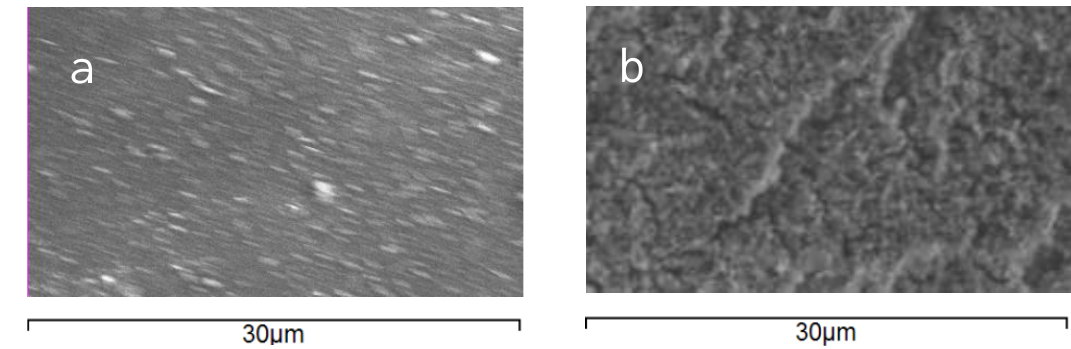
Figure 5. SEM images of MPF-34 membrane surface before ( a ) and after ( b ) filtration. Table 3. Elemental composition of the membrane surfaces from EDS measurements. Element